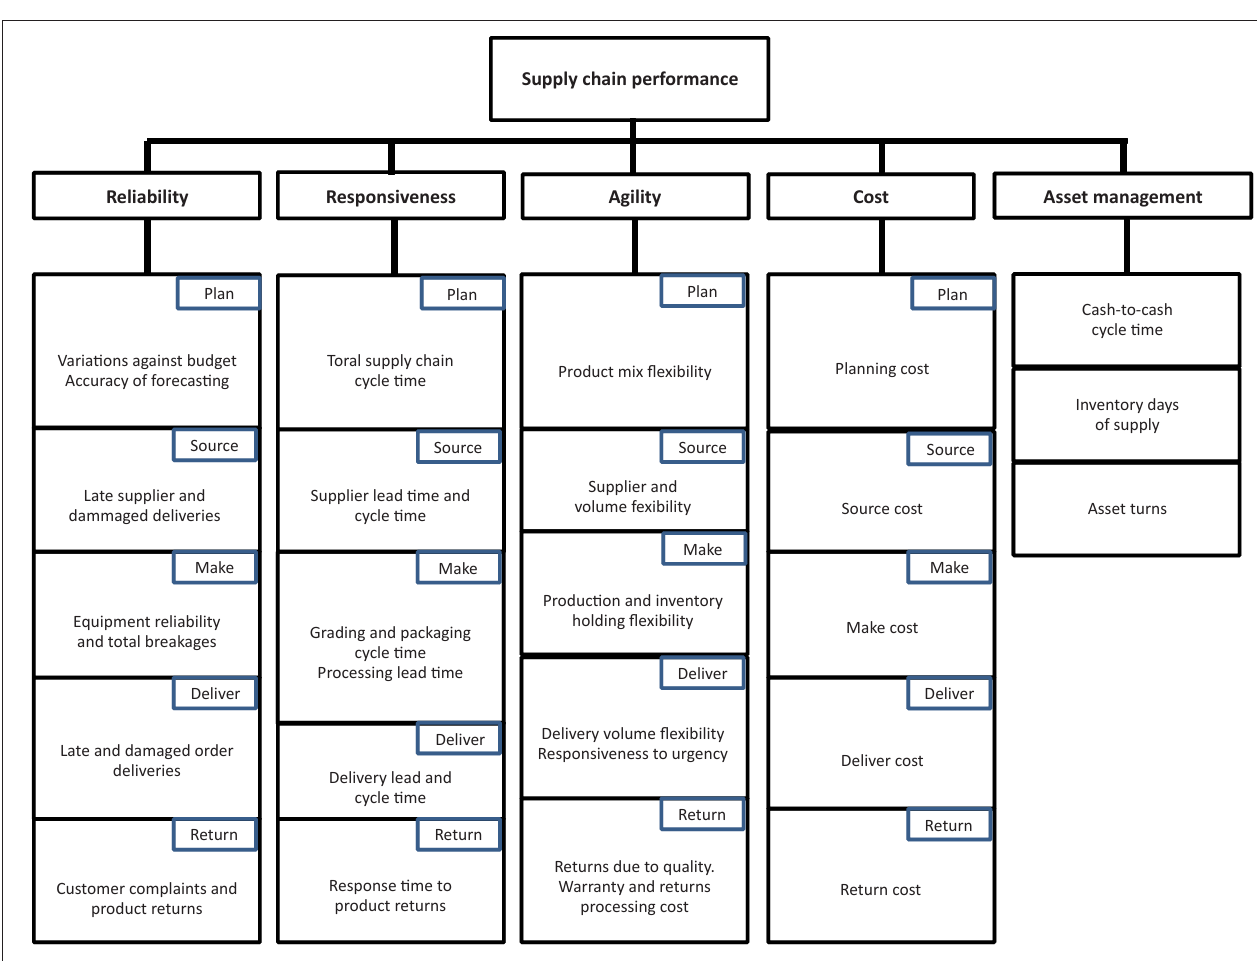
FIGURE 1: Five core attributes identified by SCOR as presented to